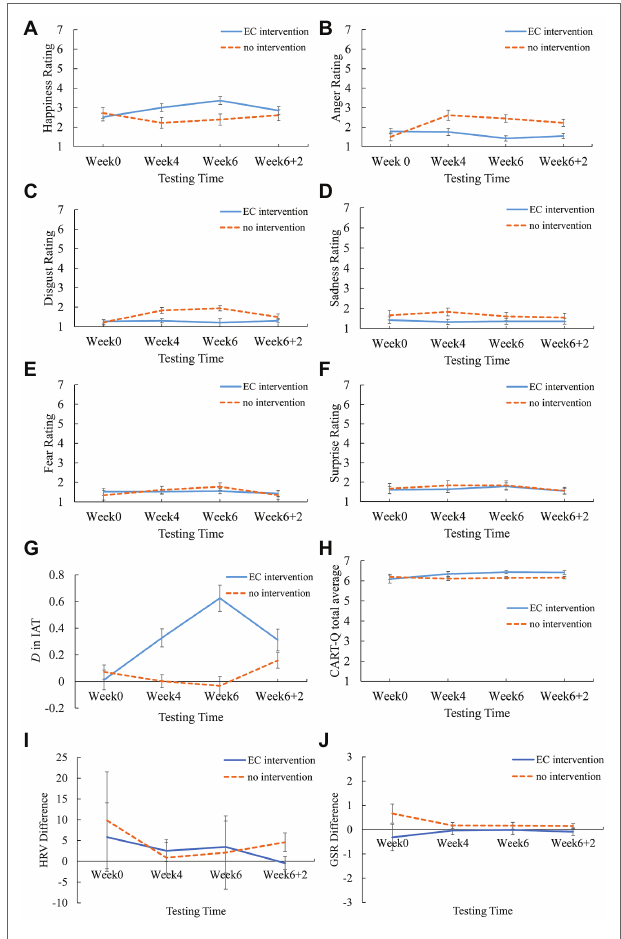
FIGURE 4 | The variation of (A–F) the emotion ratings (happiness, anger, disgust, sadness, fear, surprise), (G) the D score in IAT, (H) the CART-Q scores, (I) the HRV, and (J) the GSR with time in the EC intervention and no intervention